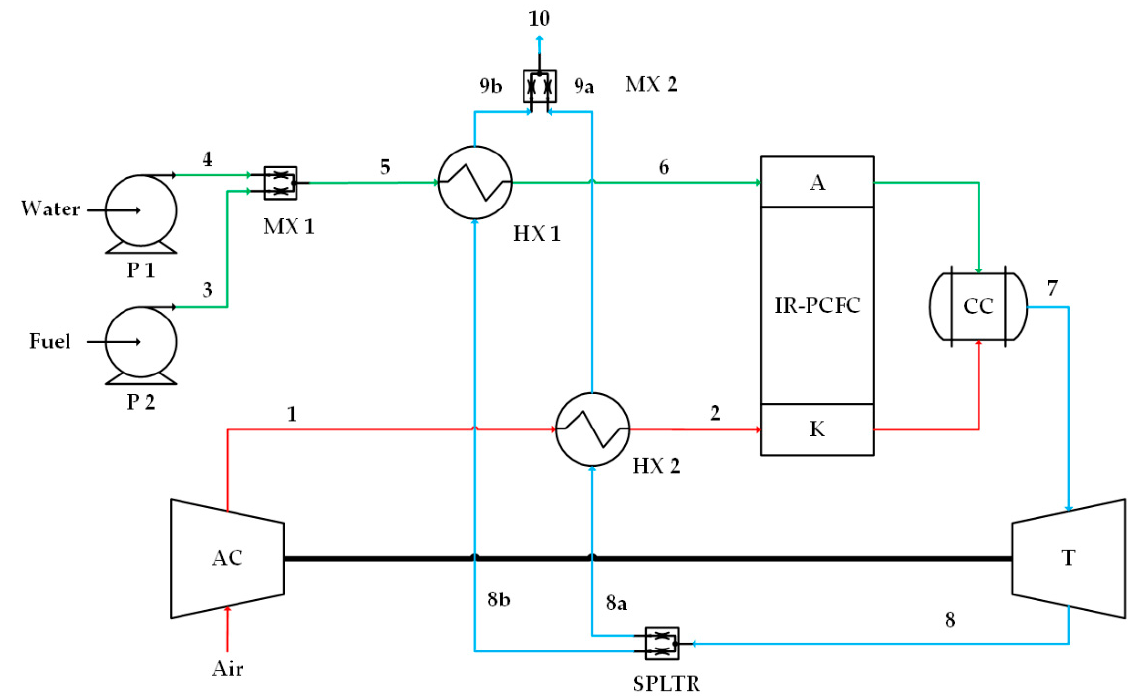
Figure 3. Case 3, high‑quality heat from turbine is proportionally distributed into the anode pre‑ heater (HX1) and cathode preheater (HX2). Numbers 1 and 2 on the red lines indicate cathode flow, numbers 3, 4, 5, and 6 on the green lines indicate anode flow, and numbers 7, 8, 8a, 8b, 9a, 9b and 10 on the blue lines indicate combustion flow.